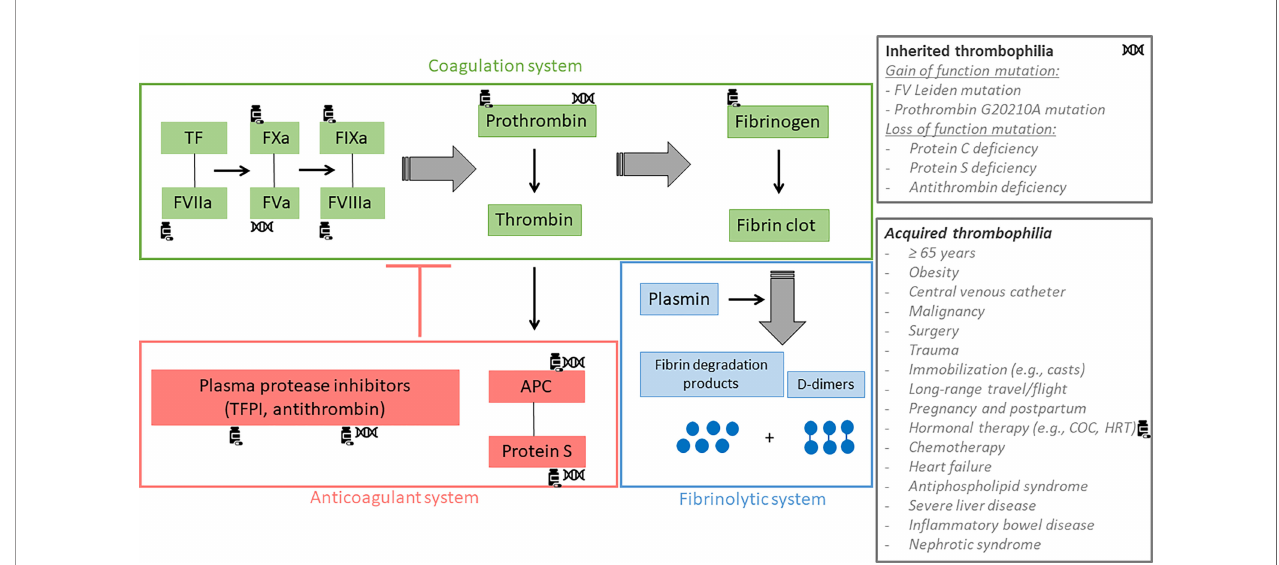
FIGURE 2 | Coagulation, fi brinolytic and anticoagulant systems. The green rectangle refers to the coagulation system, the blue rectangle refers to the fi brinolytic system and the red rectangle refers to the anticoagulant system. Tissue factor (TF) plays an important role in the initiation of the coagulation process. Combined with activated factor VII, the complex activates FIX and FX. Subsequently, FIXa and FXa form two complexes with activated FV and activated FVIII respectively, leading to the conversion of prothrombin into thrombin. Once formed, thrombin cleaves fi brinogen to form the fi brin clot which is then degraded by the fi brinolytic system whose the main effector is plasmin. This releases fi brin degradation products and D-dimers. Thrombin also activates the protein C system in order to down regulate its own production. Indeed, once activated by thrombin, protein C forms a complex with protein S in order to inactivate factor Va and factor VIIIa, the two main co- factors of the intrinsic (IXa-VIIIa) and the prothrombinase (Xa-Va) complexes. The generation of thrombin is also regulated by other protease inhibitors like antithrombin (AT) and tissue factor pathway inhibitor, widely known as TFPI. Inherited and acquired thrombophilia can disrupt the coagulation, the fi brinolytic or the anticoagulant system leading to an increased risk of venous thromboembolism. Coagulation factors impacted by inherited thrombophilia are marked with the DNA- symbol and those impacted by the intake of combined oral contraceptives (COC) are marked with the drug-symbol. APC, activated protein C; TF, tissue factor; TFPI, tissue factor pathway